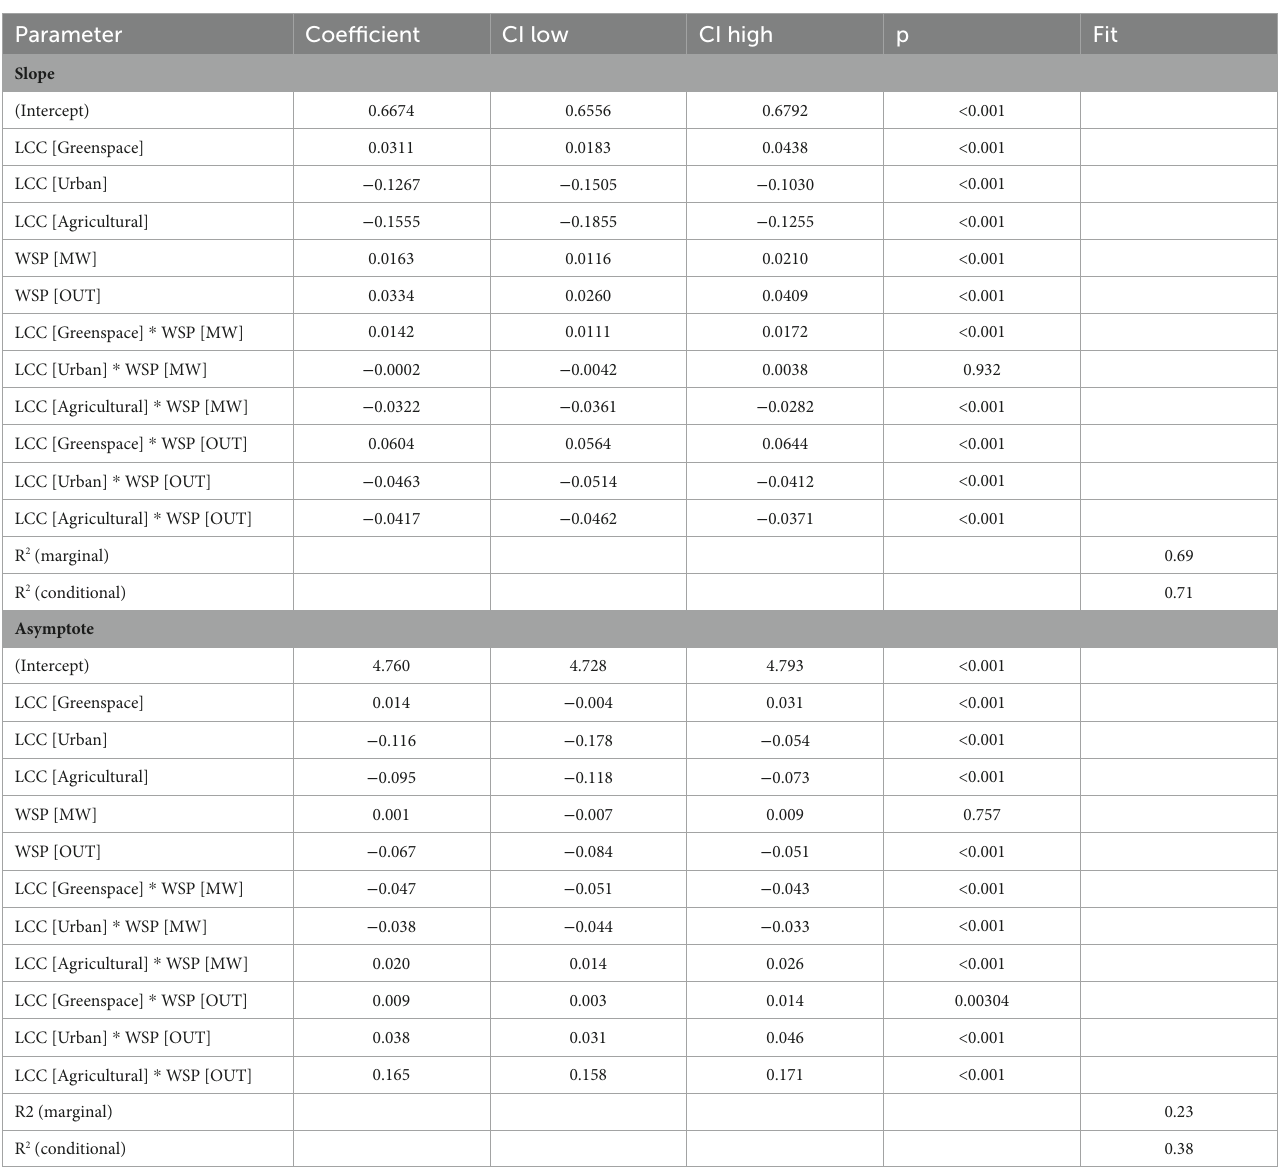
TABLE 2 Results of GLMMs for slope and